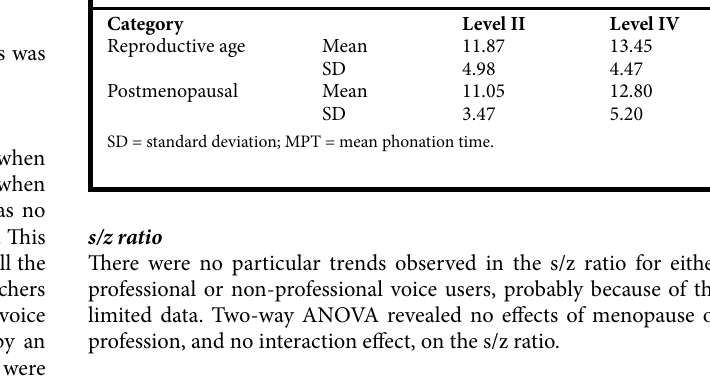
Table VI. Means and SDs of MPT values (in seconds) across the different groups